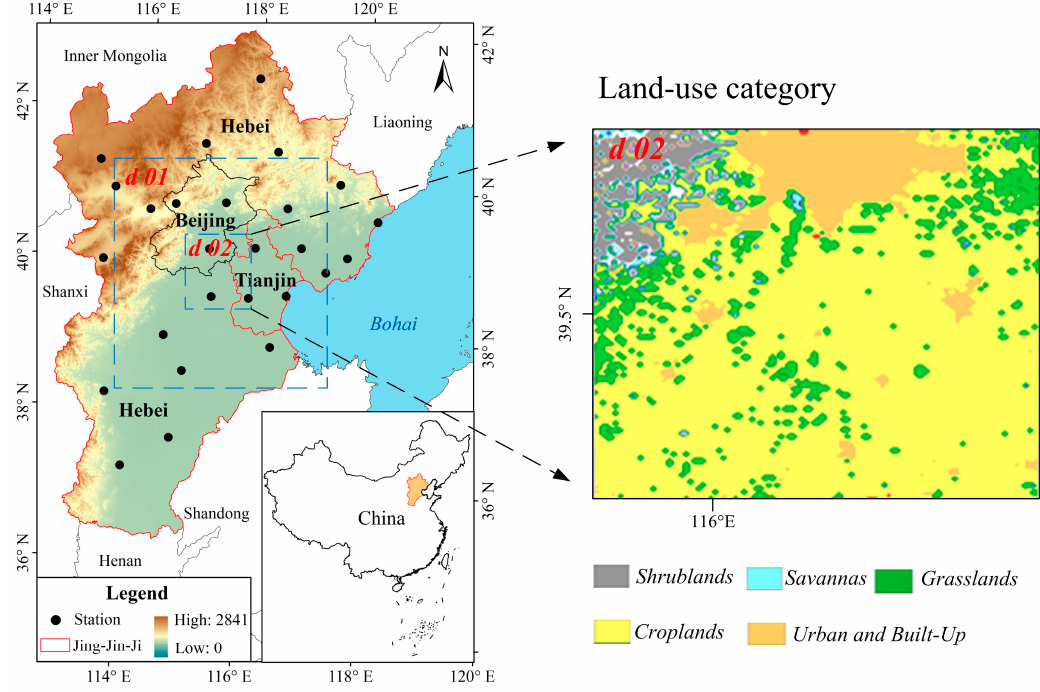
Figure 1. Location of the study area and the land-use category distribution in the model domain.